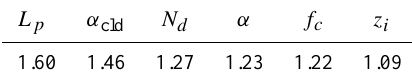
Table 2. Ratio of the time mean of the spatial variance of each vari- able at a 1 ◦ × 1 ◦ grid resolution compared with that using a 2 ◦ × 2 ◦ grid